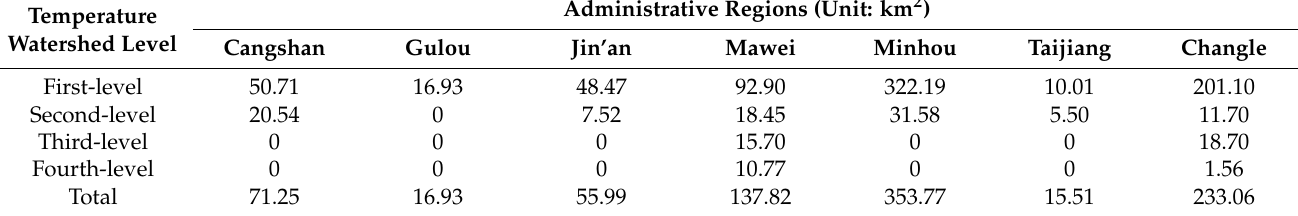
Table 1. Spatial distribution of temperature watershed.